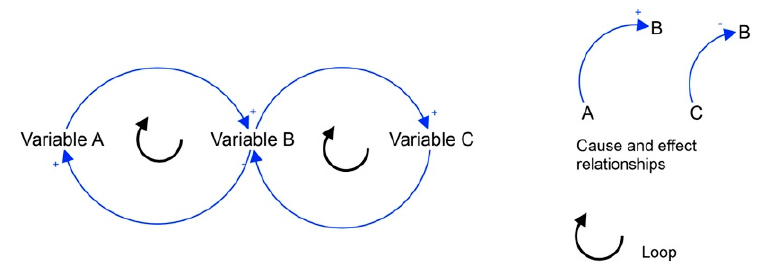
Figure 3. Causal loop general structure.